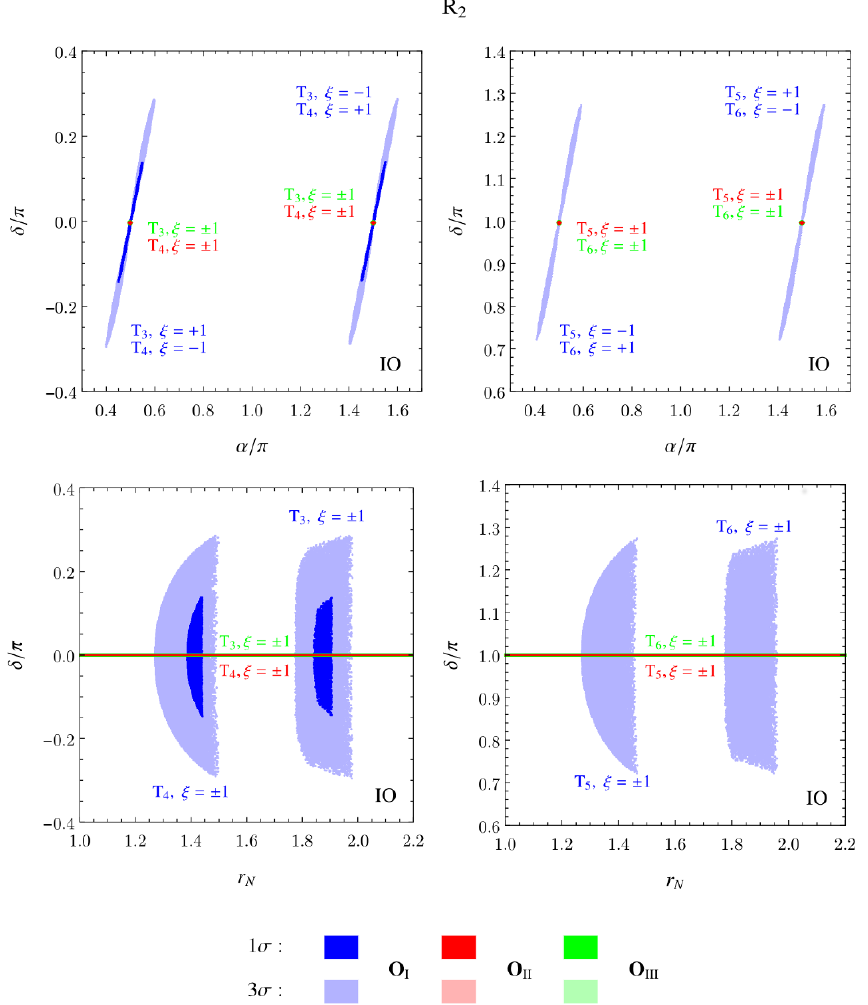
Figure 4 . Allowed regions in the ( (cid:11) , (cid:14) ) and ( r N , (cid:14) ) planes (upper and lower plots, respectively) for the (R 2 , T 3 ; 4 , (cid:24) = (cid:6) 1) and (R 2 , T 5 ; 6 , (cid:24) = (cid:6) 1) combinations (left and right plots, respectively), in the case of IO and O of the types O I-III . The light (dark) colored regions were obtained varying (cid:18) ij and (cid:1) m 2 within the 3 (cid:27) (1 (cid:27) ) experimental ranges given in table ij